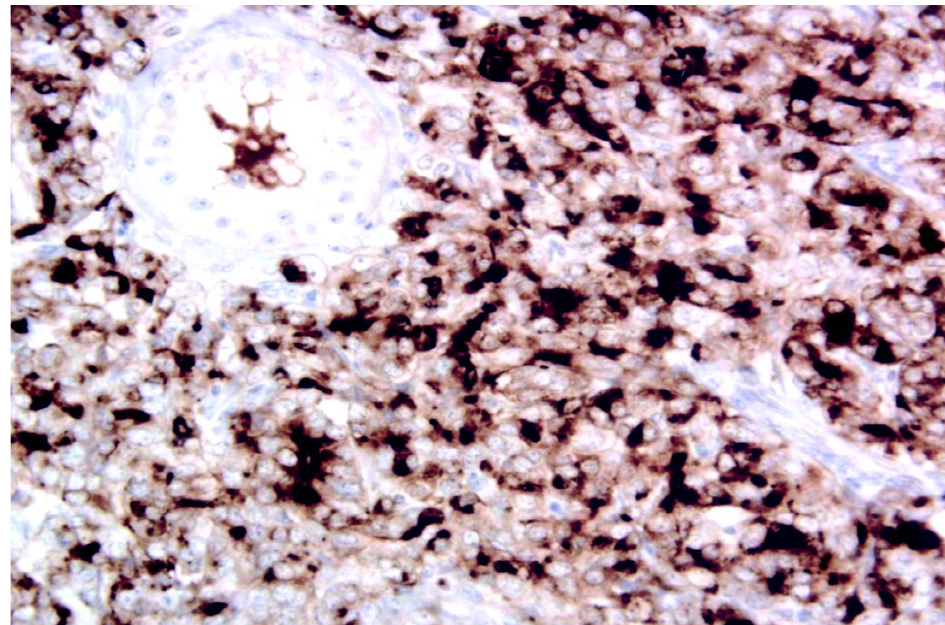
Figure 2 – Positive expression of prostate specific antigen (PSA) by metastatic cells involving a seminiferous tubule (Avidin-biotin peroxidase, anti-PSA antibody 1:20,